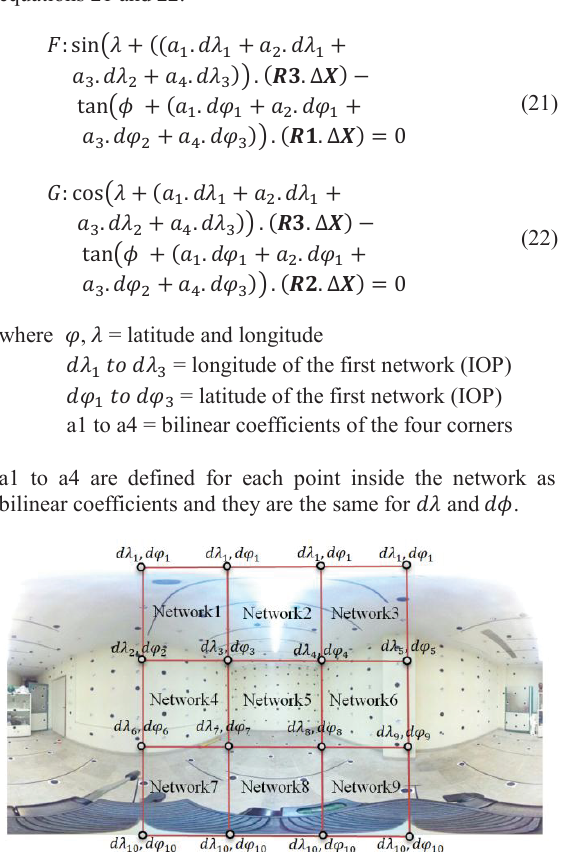
Figure 5. Representation of nine networks on the central